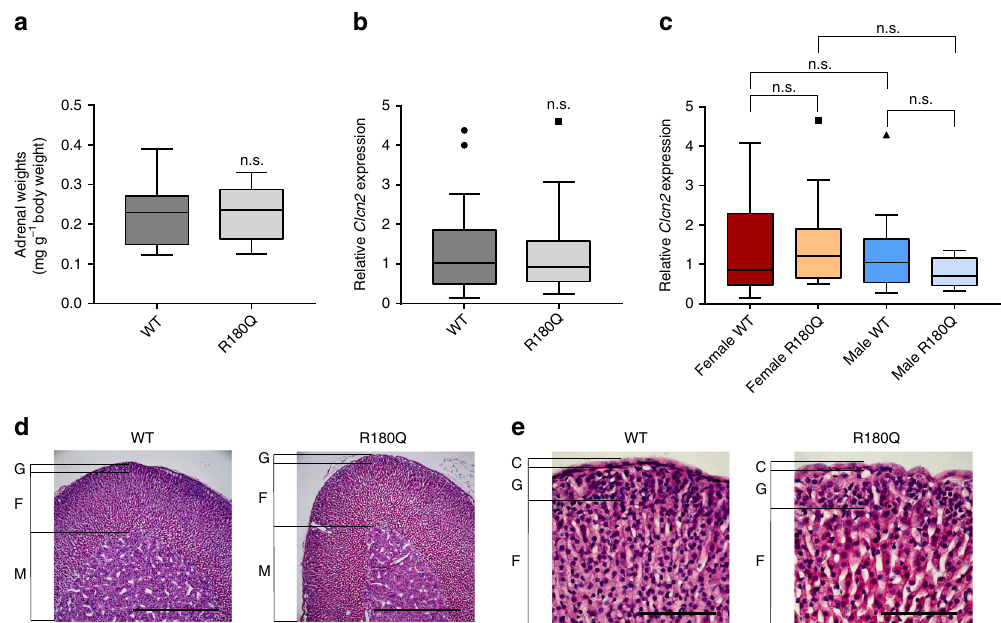
Fig. 2 Adrenal phenotype of Clcn2 R180Q/ + mice. a Adrenal weights (normalized to body weight) are not signi fi cantly different between WT ( N = 31; 0.22 ± 0.01 mg g − 1 ) and Clcn2 R180Q/ + mice ( N = 30; 0.22 ± 0.01 mg g − 1 ; P = 0.599; Mann – Whitney test). b Adrenal expression of Clcn2 is unchanged in Clcn2 R180Q/ + compared to WT ( Clcn2 R180Q/ + : N = 25, 1.24 ± 0.2, WT: N = 32, 1.34 ± 0.19; P = 0.8235; Unpaired t test of log-transformed fold change; t = 0.2241; df = 55). c Sex speci fi c Clcn2 expression does not differ between WT and Clcn2 R180Q/ + (female WT: N = 17, 1.4 ± 0.27; female Clcn2 R180Q/ + : N = 18, 1.5 ± 0.26, vs. female WT P = 0.8999; male WT: N = 15, 1.28 ± 0.26, vs. female WT P > 0.9999; male Clcn2 R180Q/ + : N = 7, 0.79 ± 0.14, vs. female Clcn2 R180Q/ + P = 0.3700, vs. male WT P = 0.7845; one-way ANOVA including Sidak´s MCP of log-transformed fold change; F = 1.492; df = 53). All data ( a – c ) are speci fi ed as mean ± SEM in the legend; box plots are shown in the fi gure (box, interquartile range; whiskers, 1.5 times the interquartile range; line, median; dots, outliers); N values are biologically independent animals. n.s., p > 0.05 d, e H&E stainings of adrenal sections show unaltered morphology of Clcn2 R180Q/ + compared to WT (nine mice each, representative images). C capsule, G glomerulosa, F fasciculata, M medulla (scale bars: ( d ) 500 µ m; ( e ) 100 µ m)